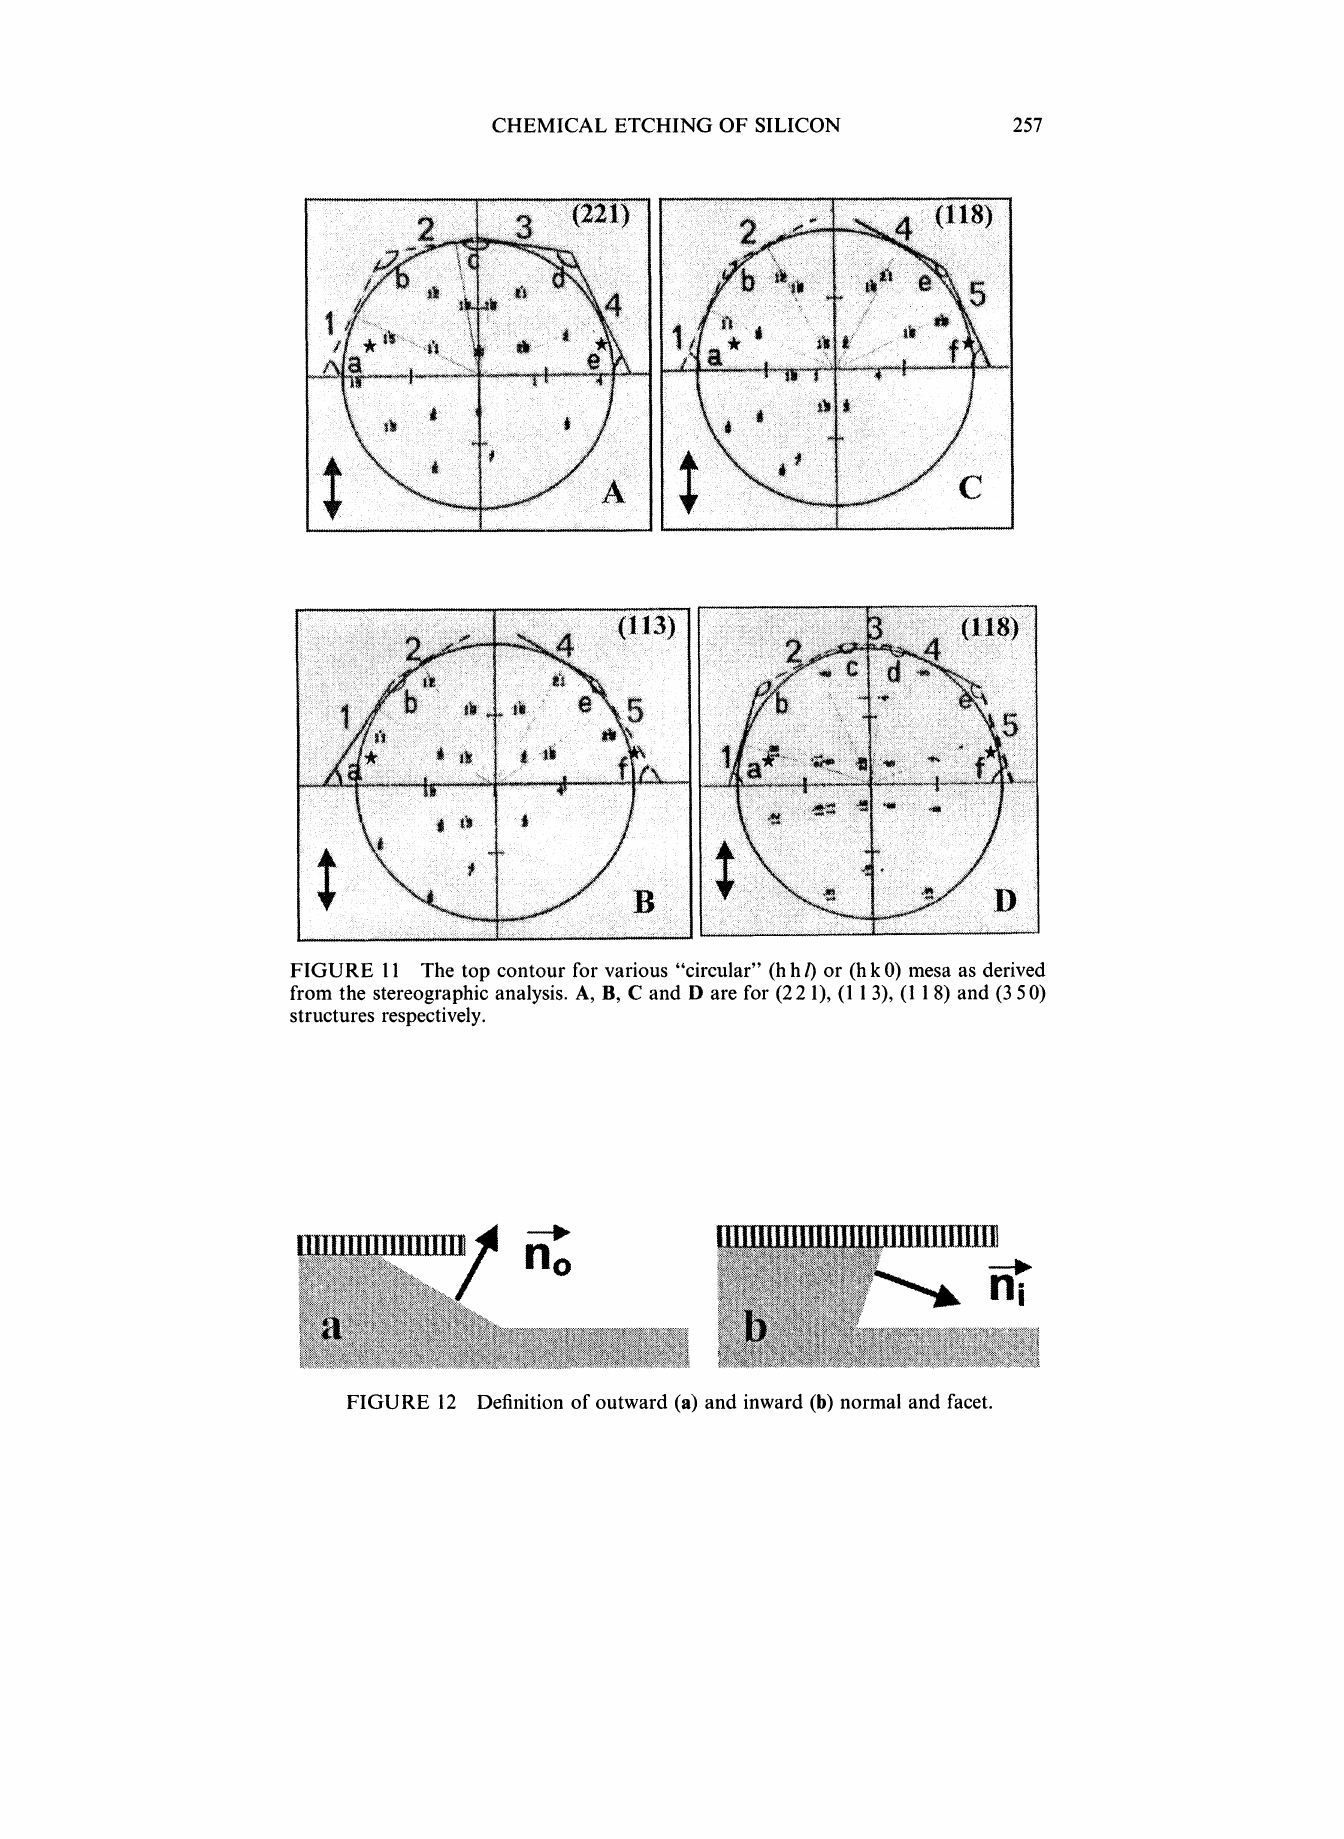
FIGURE 12 Definition of outward (a) and inward (B) normal and